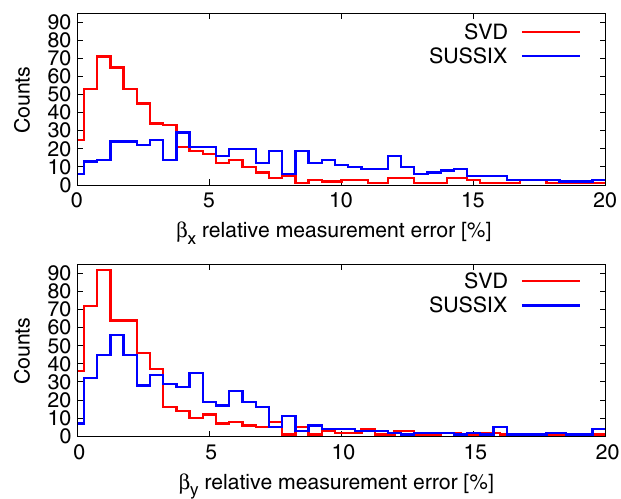
FIG. 11. (Color) Simulation of the performance of two different algorithms used to measure the (cid:2) functions. Histograms of the horizontal and vertical beta function relative measurement errors are shown on the top and bottom plots, respectively.